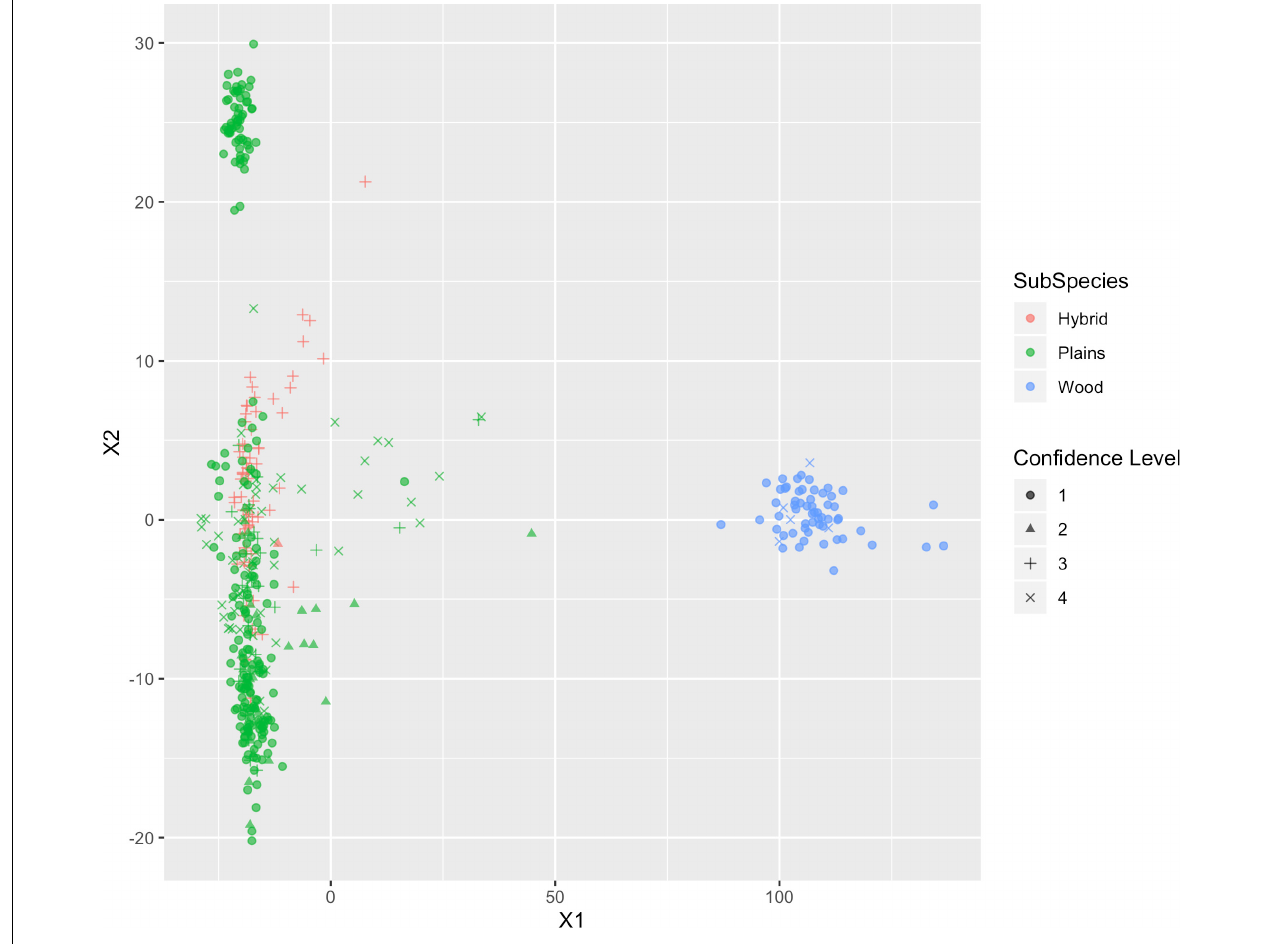
FIGURE 6 | Multi-dimensional scaling (MDS) visualization of genetic distances between plains and wood bison determined using the custom